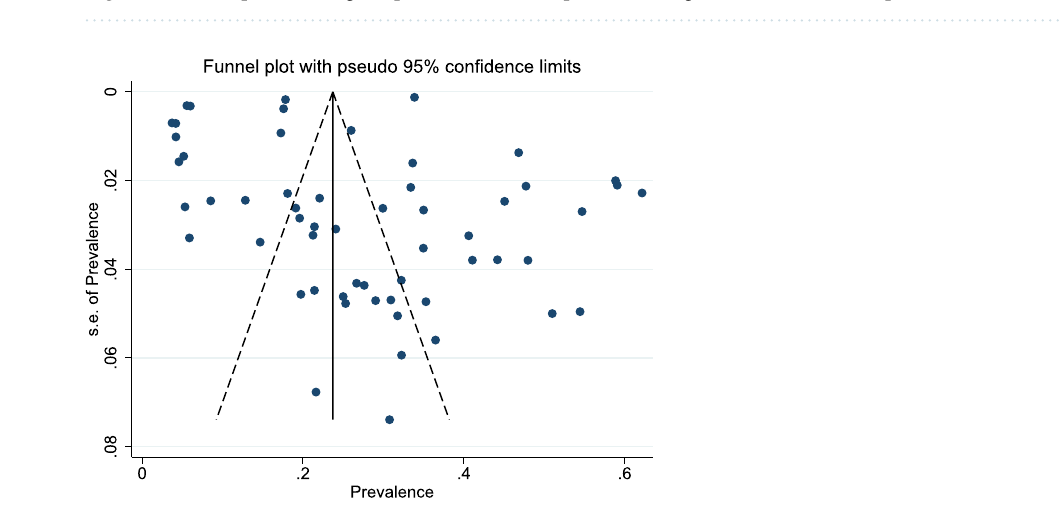
Figure 3. Funnel plot to check the publication